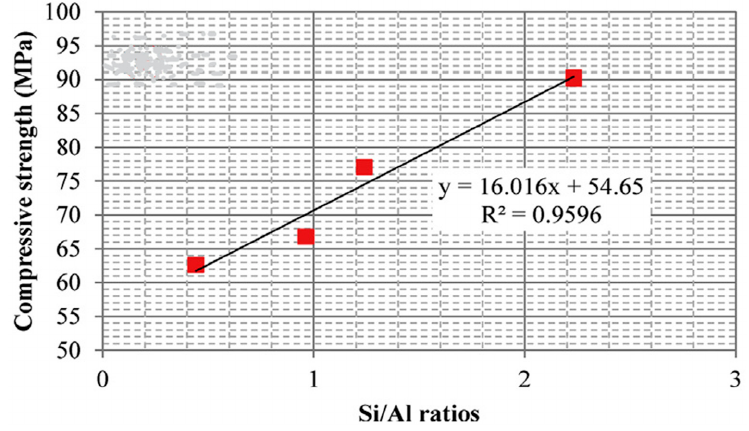
Figure 11. Compressive strength in the function of the Si/Al ratios [115].